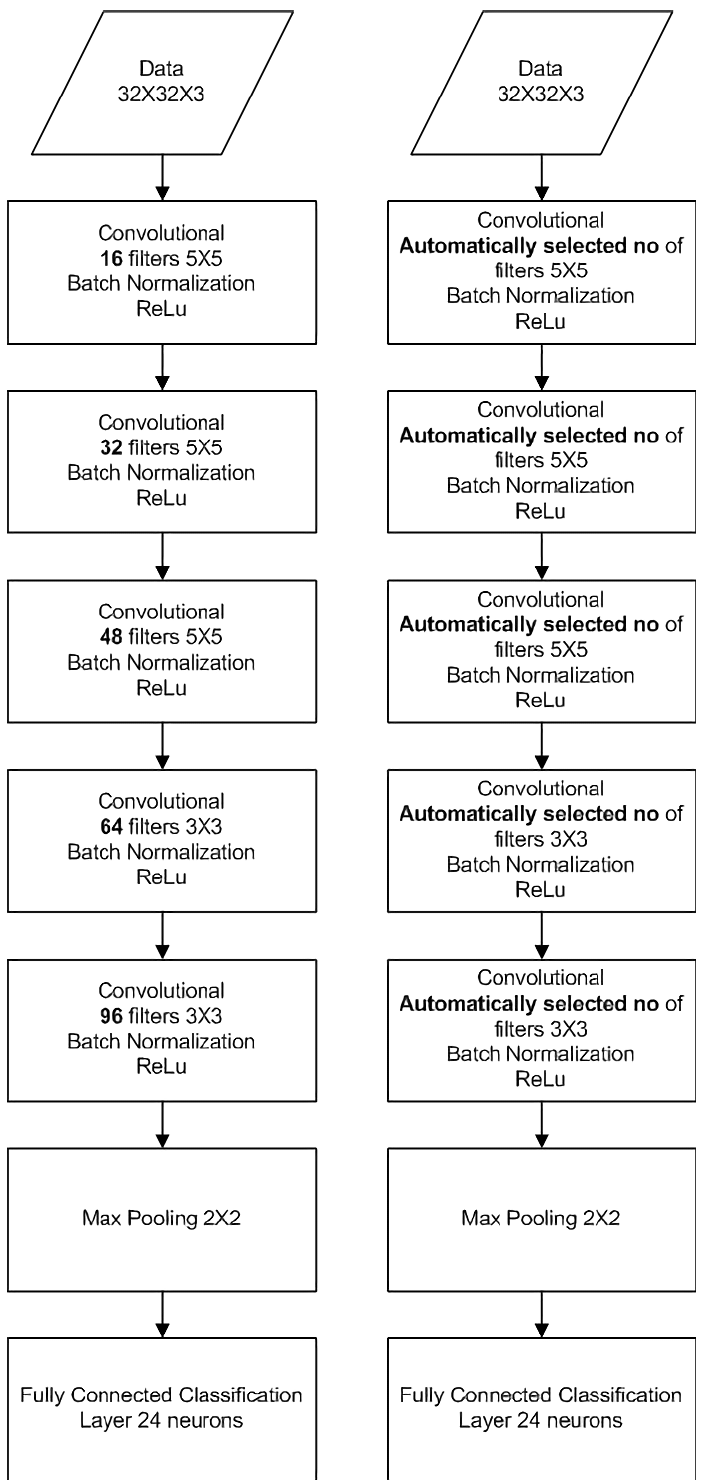
Figure 19. Vanilla CNN for Sign Language classification ( left ), Adaptive CNN for Sign Language classification ( right